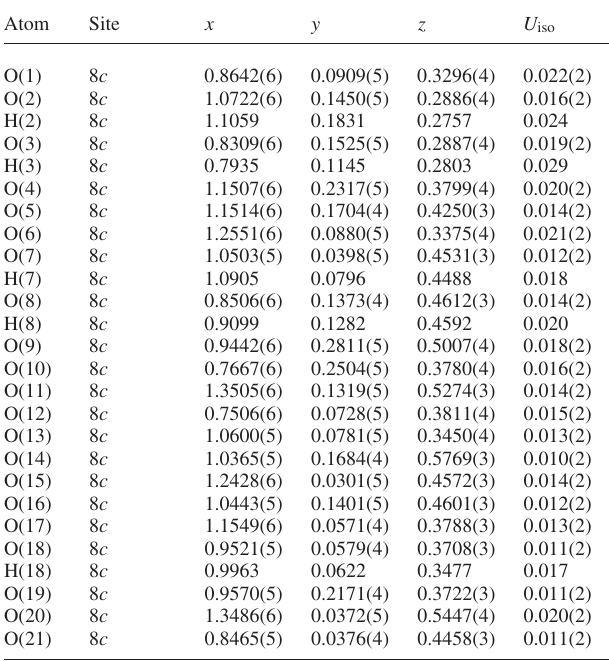
Table 2. Atomic coordinates and displacement parameters (in Å 2 )